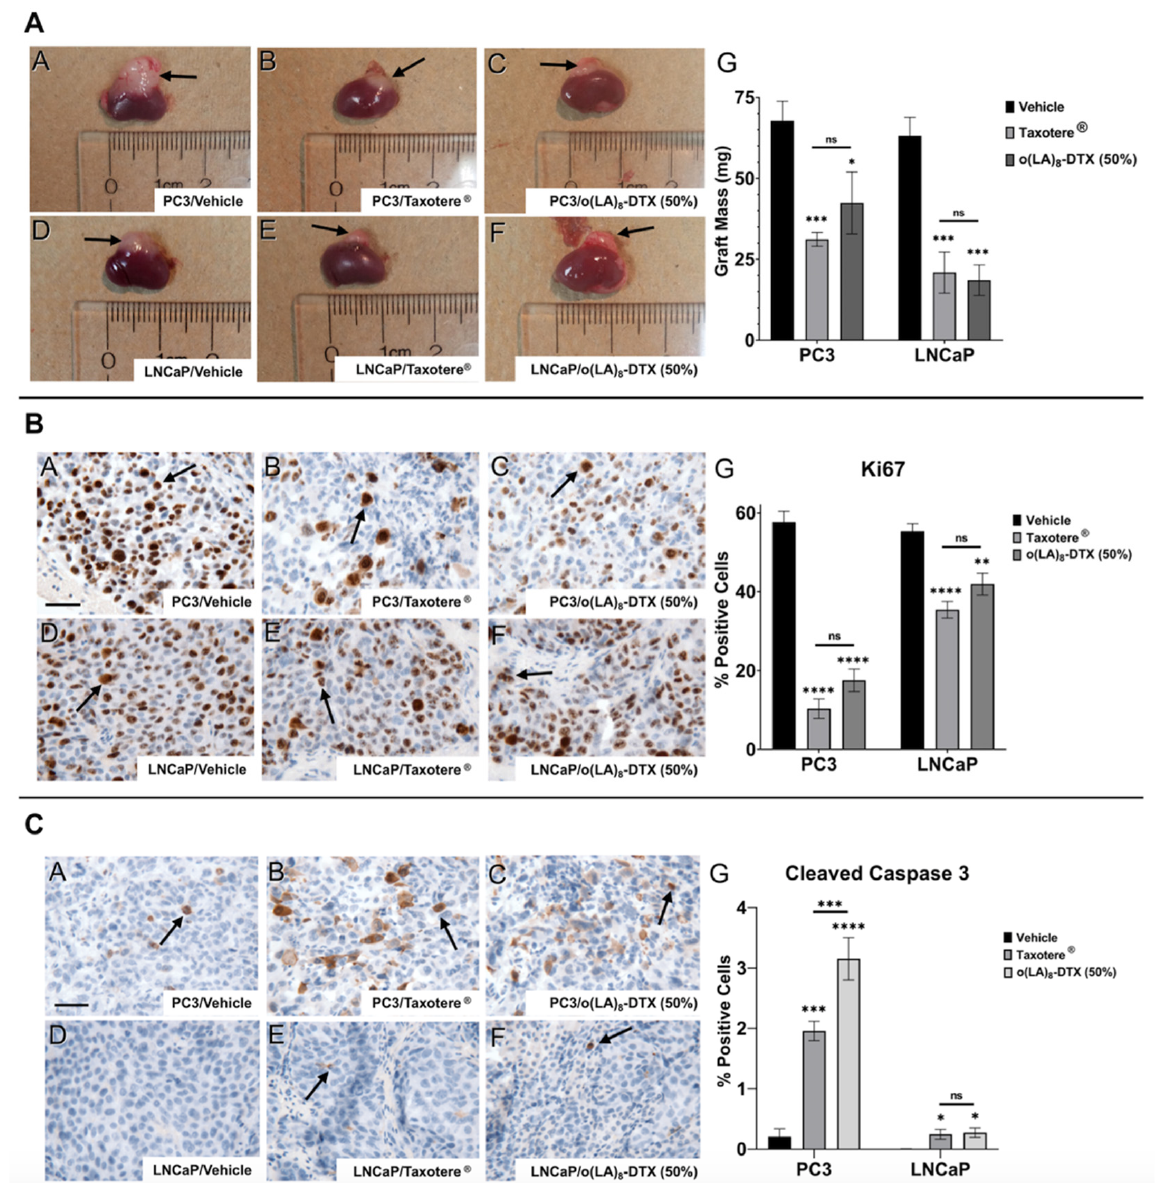
Figure 7. In vivo efficacy of o(LA) 8 -DTX-loaded micelles (n = 5 or 6; mean ± SEM). ( A ) Representative images of whole kidneys with grafted PC3 (A–C) or LNCaP (D–F) cells. Graft weights of resected tumors (G). ( B ) Representative IHC staining for Ki67, a proliferation marker, in PC3 (A–C) and LNCaP (D–F) tumors and the corresponding quantitation (G). ( C ) Representative IHC staining for cleaved caspase-3, a marker of apoptosis, in PC3 (A–C) and LNCaP (D–F) tumors and the corresponding quantitation (G). Representative scale bars in Panel A = 50 µ m. * p < 0.05; ** p < 0.01; *** p < 0.001; **** p < 0.0001.